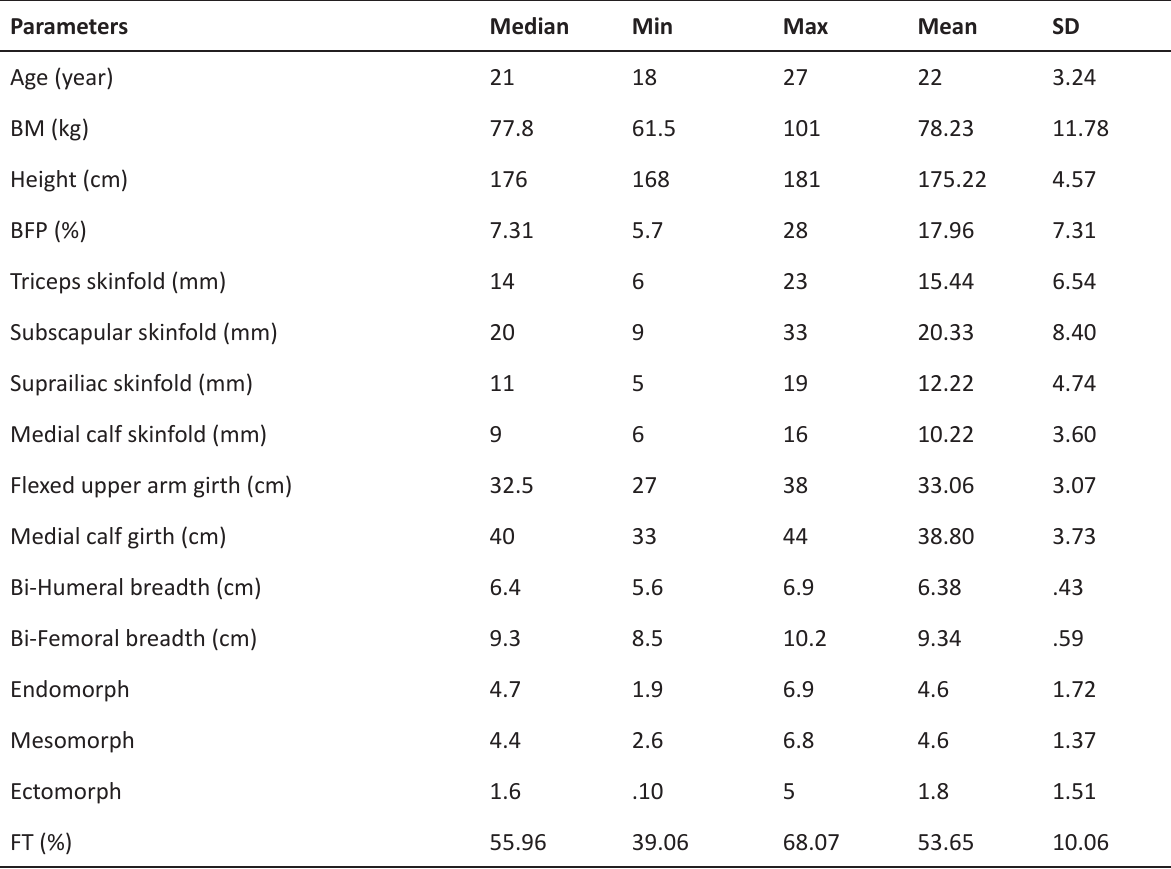
Table 1. Demographic information, somatotype components, and estimated fast-twitch percentage Parameters